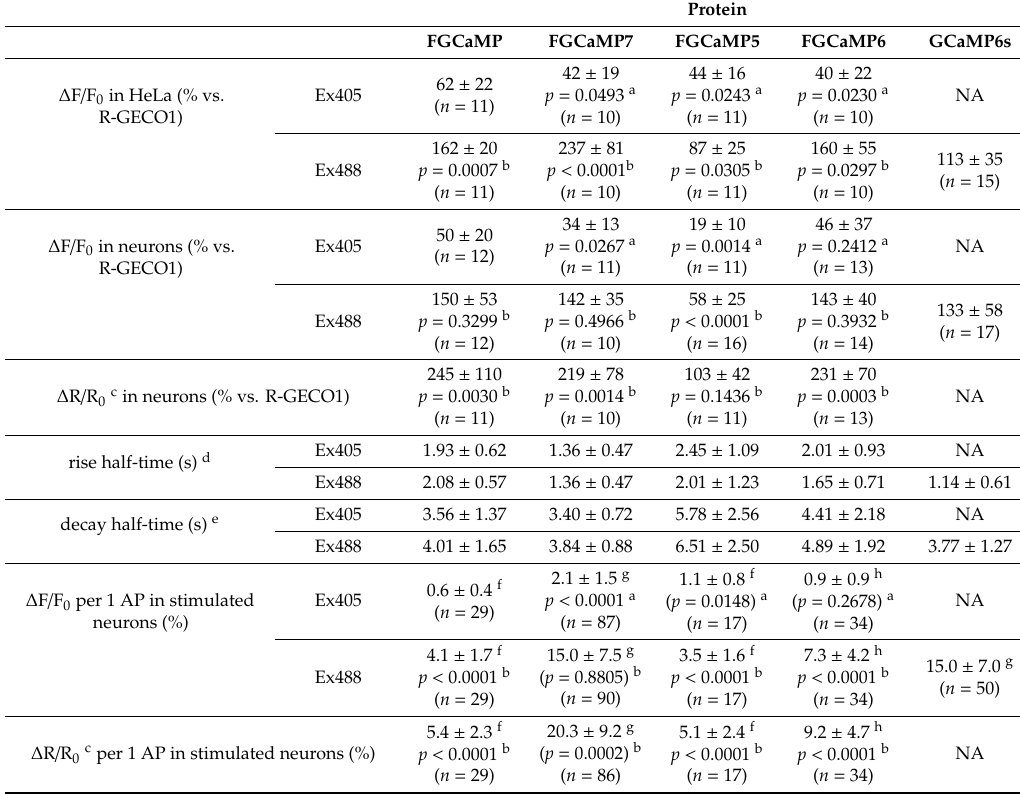
Table 2. Characteristics of FGCaMP, FGCaMP5, FGCaMP6, FGCaMP7, and GCaMP6s GECIs responses to the addition of calcium ions to HeLa cells, to spontaneous activity in dissociated neuronal cultures, and electric stimulation of dissociated neuronal